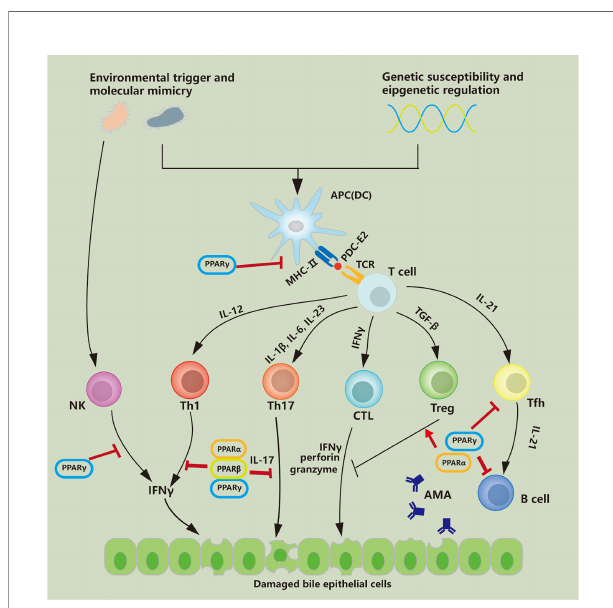
FIGURE 1 | PPAR regulates immune cells involved in PBC pathology. PDC- E2 the E2 component of the mitochondrial pyruvate dehydrogenase complex; APC antigen-presenting cell; DC dendritic cell; IFN g interferon- g , TFh follicular helper T cell; AMA anti-mitochondrial autoantibody; TGF b transforming growth factor- b ; Treg regulatory T cell; CTL cytotoxic T lymphocyte; NK natural killer; MHC-II major histocompatibility complex-II; TCR T cell receptor; Th T helper.